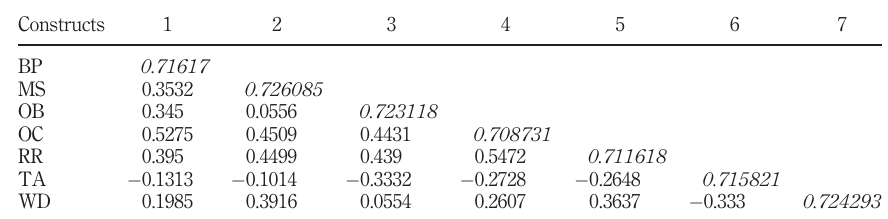
correlations and square roots of average